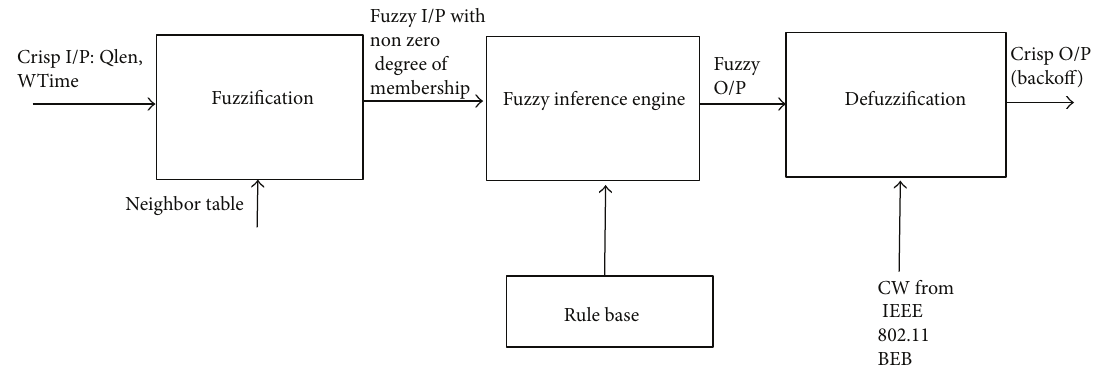
Figure 2: Steps in fuzzy